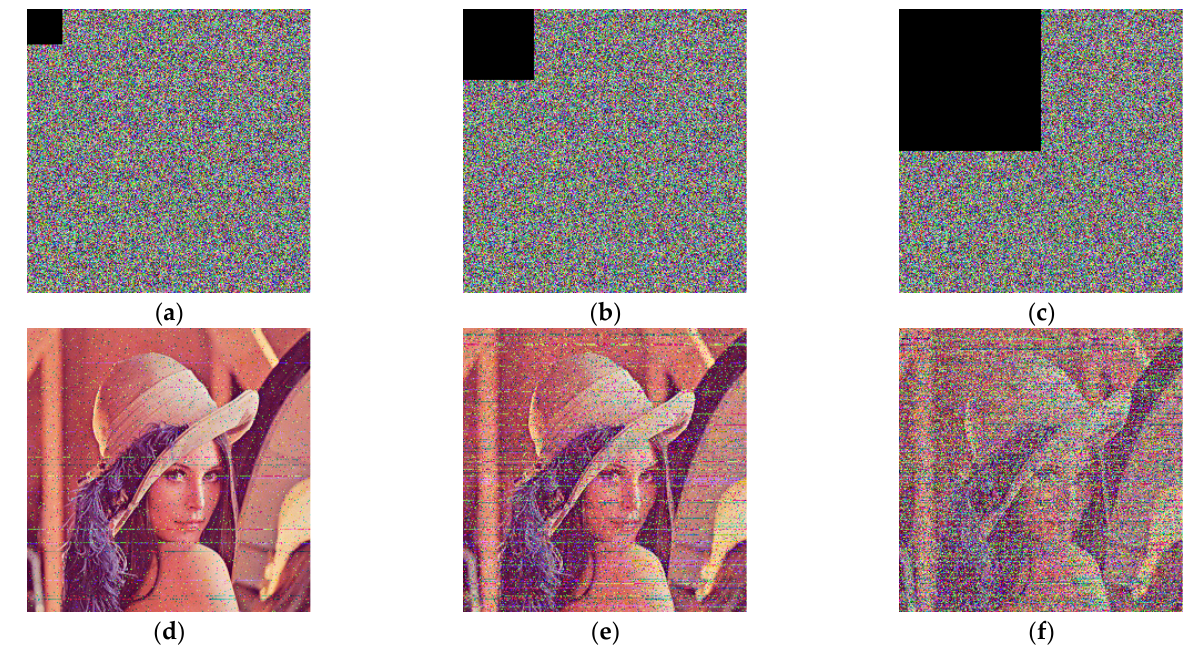
Figure 14. Occlusion test, ( a , d ) Occlusion 32 × 32 pixels, ( a , d ) Occlusion 64 × 64 pixels, ( c , f ) Occlusion 128 × 128 pixels.